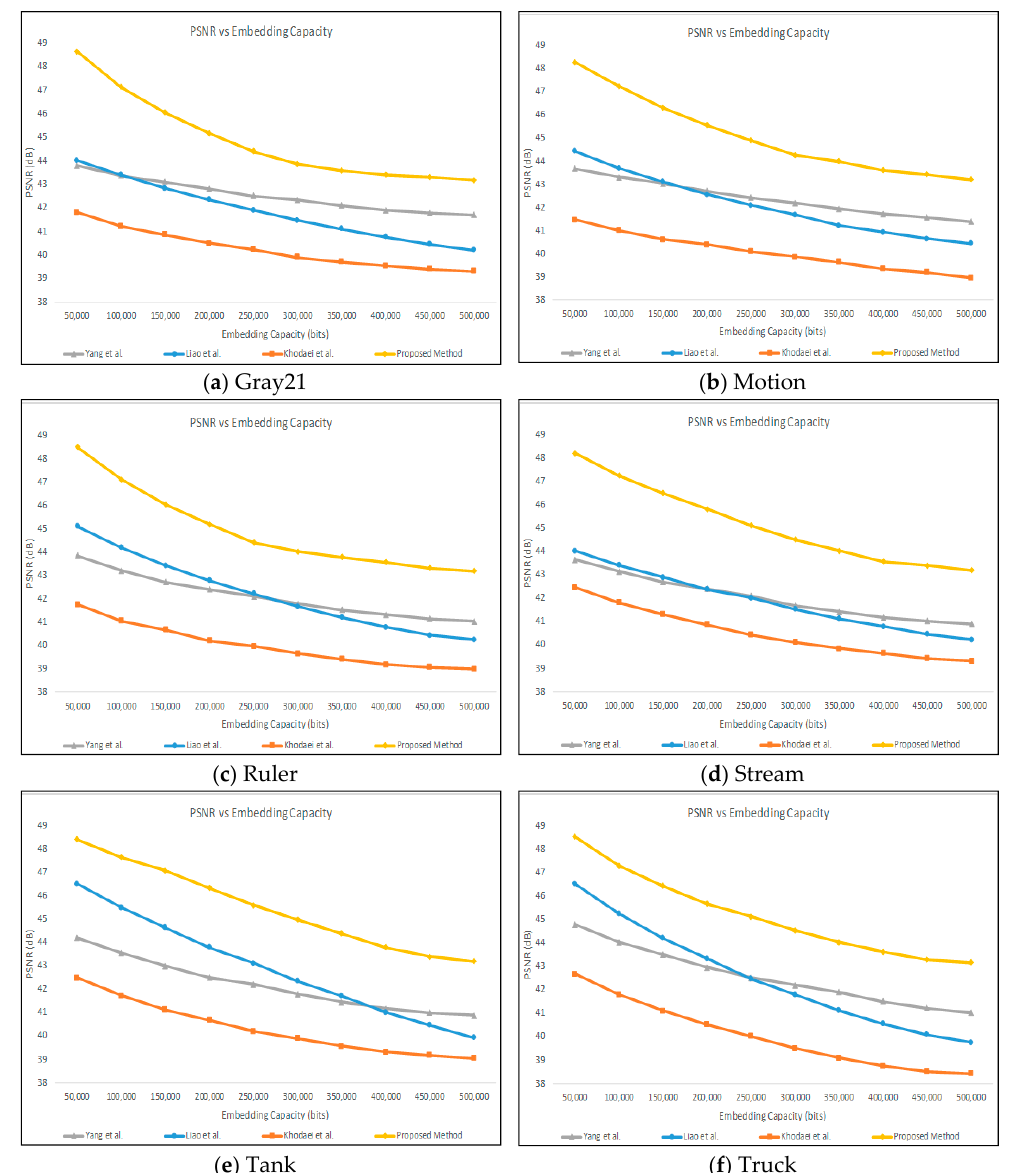
Figure 5. Comparison graphs for PSNR versus various embedding capacity from the USC-SIPI [24] dataset. The figures are ( a ) Gray21, ( b ) Motion, ( c ) Ruler, ( d ) Stream, ( e ) Tank, and ( f ) Truck. From Figure 5b of the Motion image, the proposed method obtained the maximum PSNR 43.21